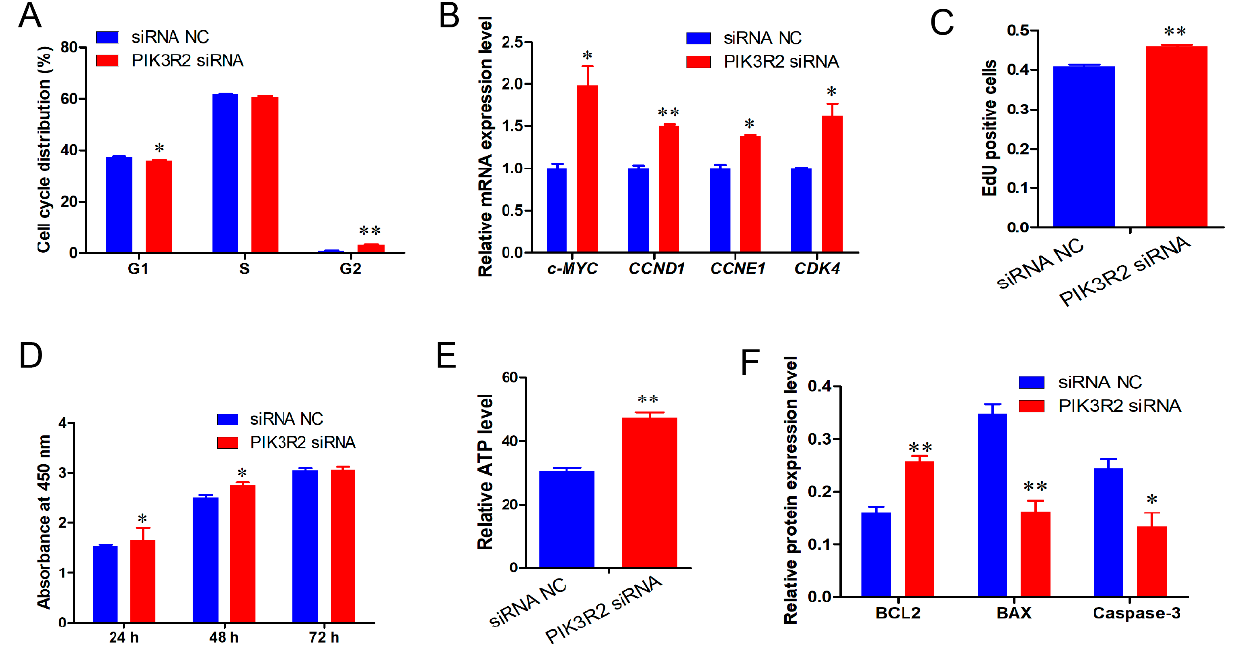
Figure 5. PIK3R2 gene inhibition promotes cell proliferation and inhibits apoptosis of immature porcine Sertoli cells. A specific siRNA was transfected into immature porcine Sertoli cells to knock down the PIK3R2 gene. ( A ) The effects of PIK3R2 inhibition on the distribution of G1, S, and G2 phases in the cell cycle. Cell cycle was analyzed 24 h after transfection using a FACSCanto II Flow Cytometer ( n = 3). ( B ) The expression of cell cycle related genes, c-MYC , CCND1 , CCNE1 , and CDK4 , were measured using the qPCR assay ( n = 3). The pig-TBP gene was used as the internal control. ( C , D ) The effects of PIK3R2 siRNA on cell proliferation was detected using EdU corporation ( C ) and CCK-8 ( D ) assays ( n = 3). ( E ) The relative ATP levels were measured by an ELISA assay. ( F ) The protein expression of cell survival-related genes was measured using a Western blot assay. The β -actin gene was used as the internal control. Data are presented as the mean ± SEM, * p < 0.05 and ** p < 0.01.